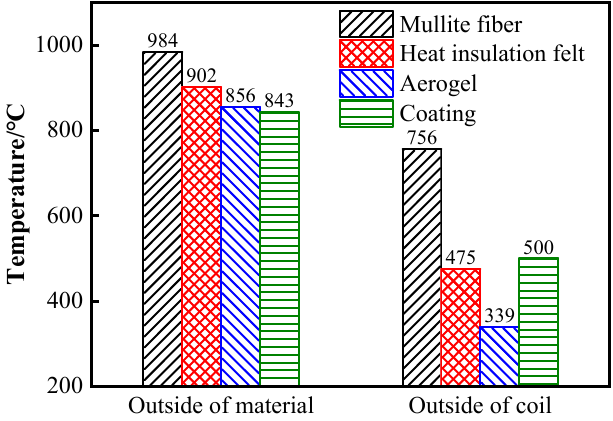
Figure 7. Heat insulation effect of different heat insulation materials at t = 370 min.